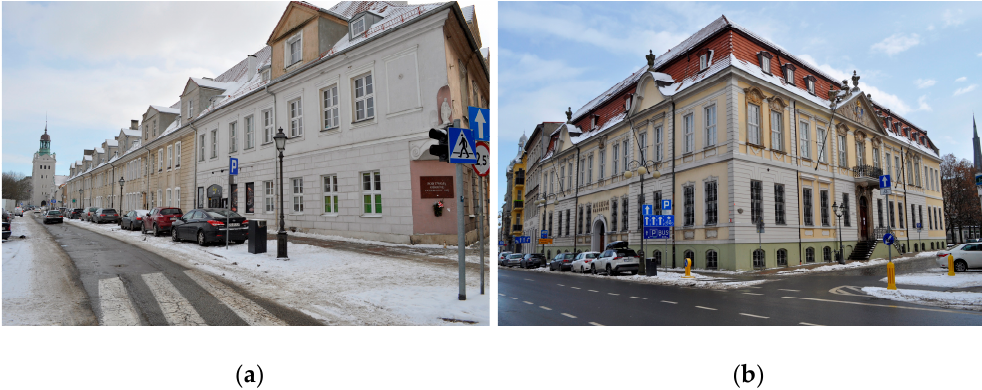
Figure 2. Prussian baroque in Szczecin, the buildings shown in both photos were funded by Frederick Wilhelm I. Their stylish forms and sculptural decoration emphasized the prestige and power of royal authority. Buildings of power (Table 2010. Znaniecki 1938): ( a ) Professors’ Houses (source: created by author); ( b ) Pomeranian State Parliament (source: created by author).